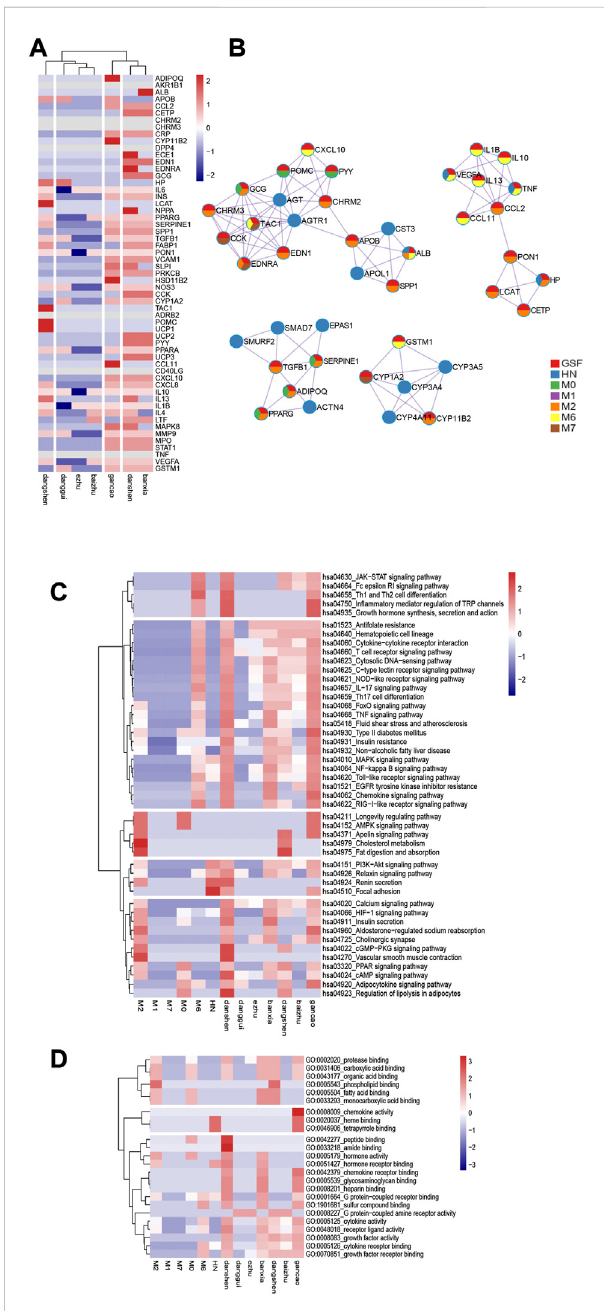
FIGURE 4 Characteristics of the GSF pathway. (A) Target characteristics of GSF. (B) GSF and HN interactive network. (C) and (D) are the KEGG pathway and GO enrichment heatmaps of the GSF and disease modules.Inthemap, theaverage number ofenrichedgenes is0; numbers higher than the average are shown in red, and numbers lower than the average are shown in